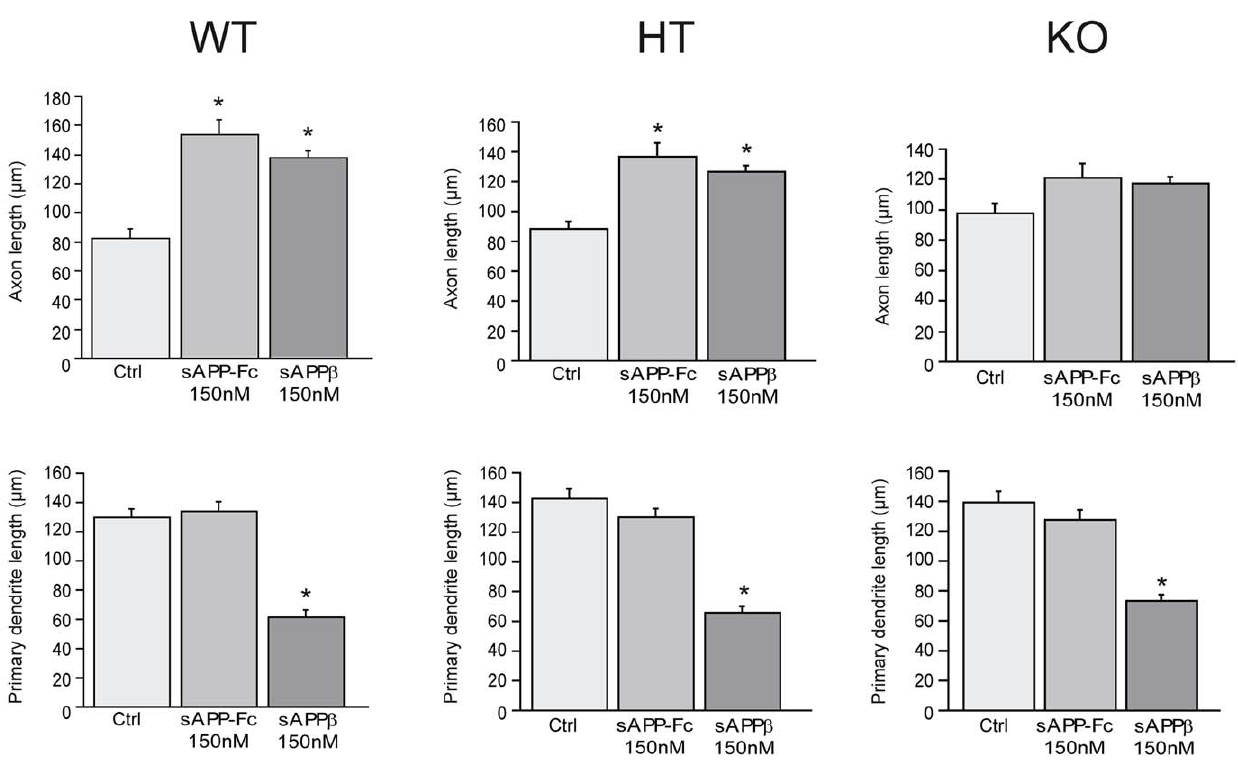
Figure 5. The primary cortical neurons from E16 homozygous knock out embryos for Egr1 do not respond to sAPPs. 150 nM sAPP-Fc or sAPP b were added on 1DIV primary neurons from Egr1 wild type (WT), heterozygous (HT) and homozygous (KO) embryos. Morphometric analysis was performed 96 hours later. Upper row: A significant increase of axonal outgrowth is observed with sAPP-Fc and sAPP b for neurons from WT and HT embryos but not from KO neurons (WT: control (Ctrl) vs sAPP-Fc: p , 0.0001, control vs sAPP b : p , 0.0001; HT: control vs sAPP-Fc: p , 0.001, control vs sAPP b : p , 0.0001; KO: control vs sAPP-Fc: NS, control vs sAPP b : NS). Lower row: Primary dendrite length is significantly decreased for sAPP b in the 3 genotypes (WT: control vs sAPP-Fc: NS, control vs sAPP b : p , 0.0001; HT: control vs APP-Fc: NS, control vs sAPP b : p , 0.0001; KO: control vs APP-Fc: NS, control vs sAPP b : p , 0.0001). The data presented are the mean of 3 independent experiments. Statistical analysis was done with ANOVA and Scheffe’s post-hoc test.